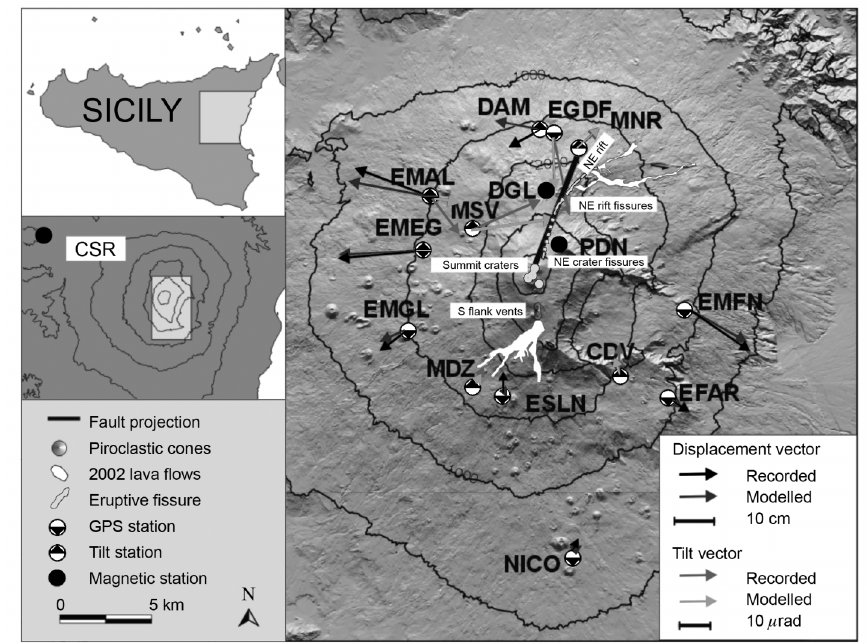
Fig. 5. Schematic map of the 2002-2003 Etna eruption showing lava flows erupted from south and NE-trend- ing fissures. Locations of GPS, tilt and magnetic stations are also indicated. Recorded and computed horizontal displacements and tilts vectors are shown as